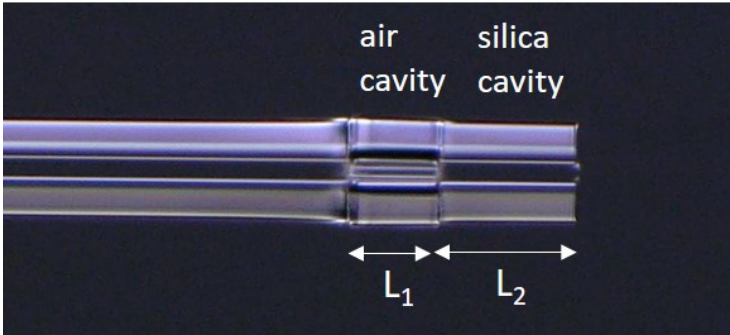
Figure 4. Microscopic image of the fabricated cascaded FPI.